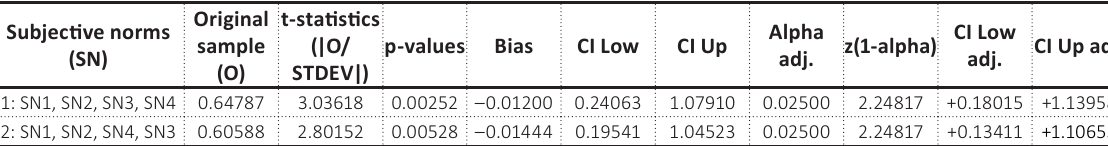
Table A1. Confirmatory Tetrad Analysis – subjective norms (SN) items